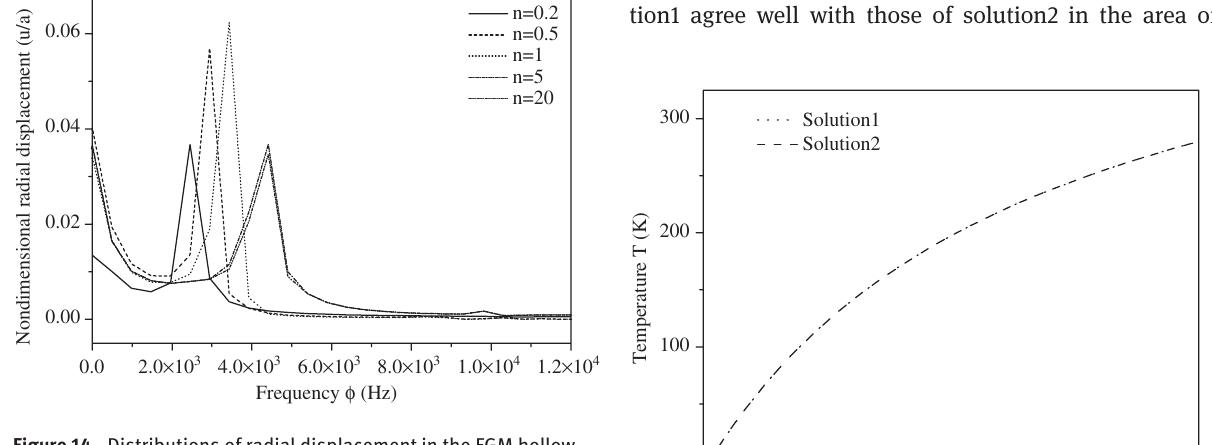
Figure 14 Distributions of radial displacement in the FGM hollow cylinder on frequency domain with different n .